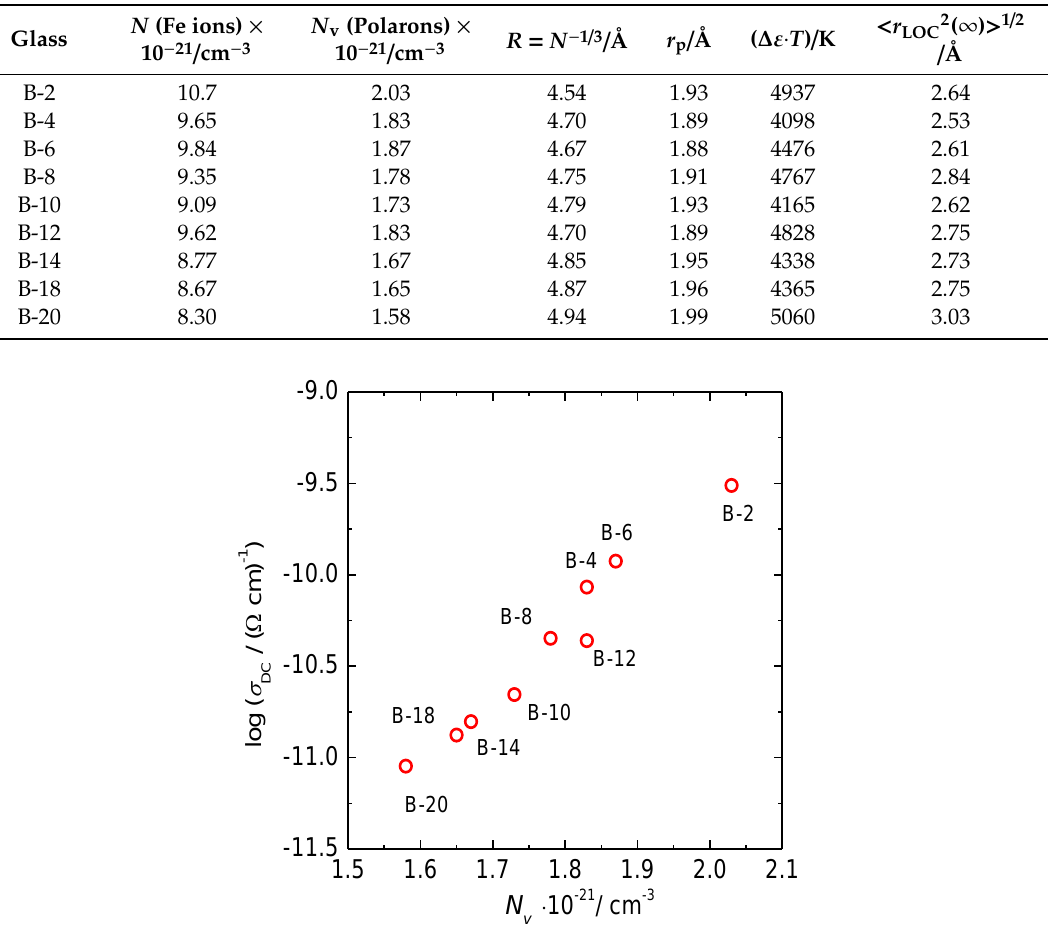
Figure 3. DC conductivity at 303 K versus polaron number density, N v, for glasses from x B 2 O 3 – (100− x )[40Fe 2 O 3 –60P 2 O 5 ] series. Table 3. Summary of quantities and parameters of polaronic transport for glasses from x B 2 O 3 – (100− x )[40Fe 2 O 3 –60P 2 O 5 ]